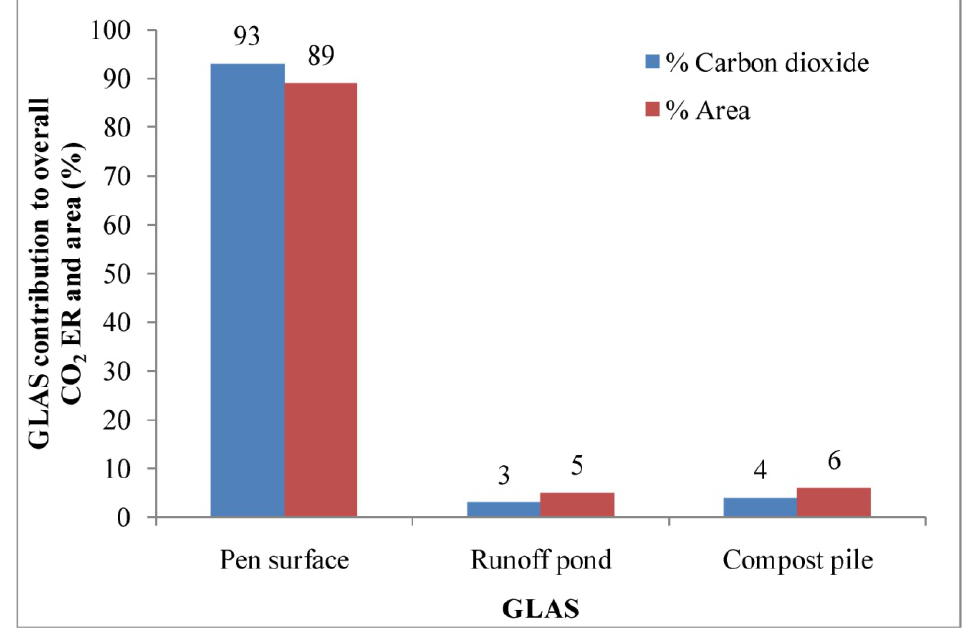
ER and area at the feedyard. 2